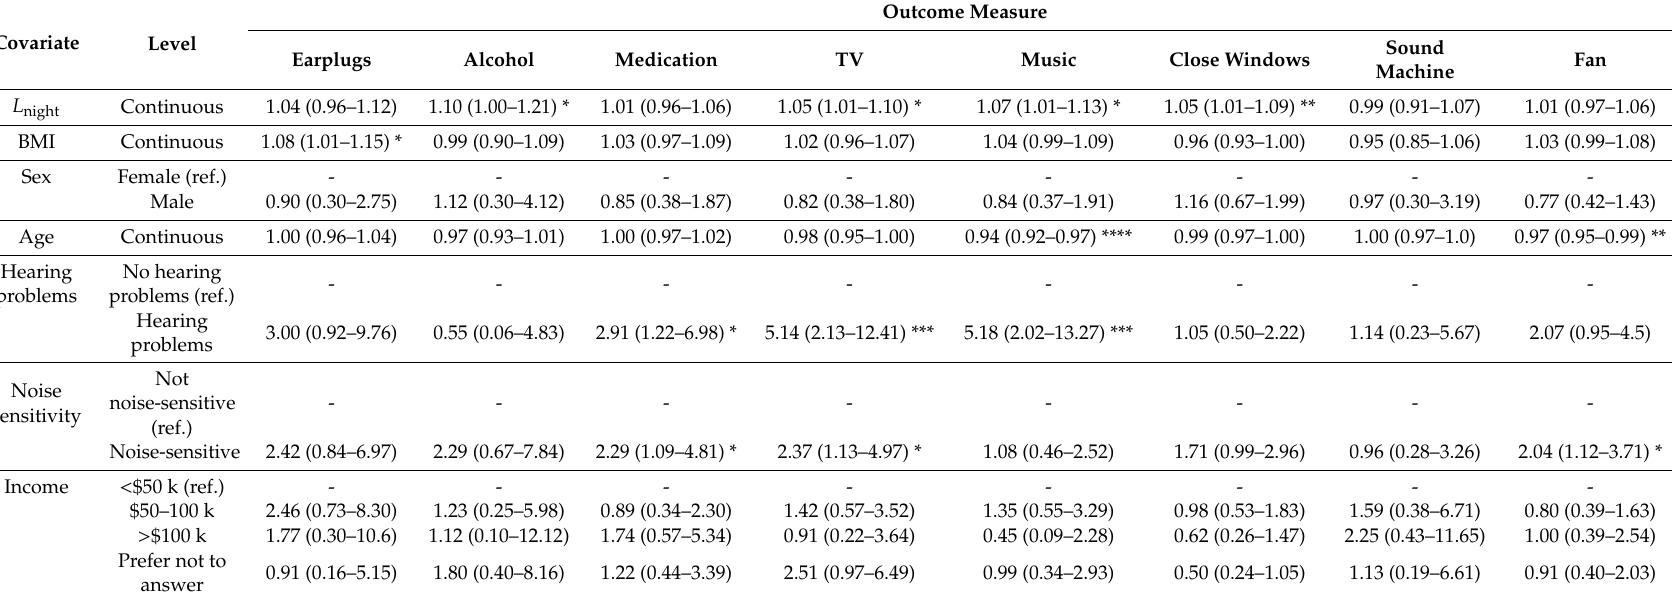
Table 5. Odds ratios (95% confidence intervals) from logistic regression models for always or often using sleep aids because of noise, adjusted for age, BMI, sex, hearing problems, noise sensitivity and income.